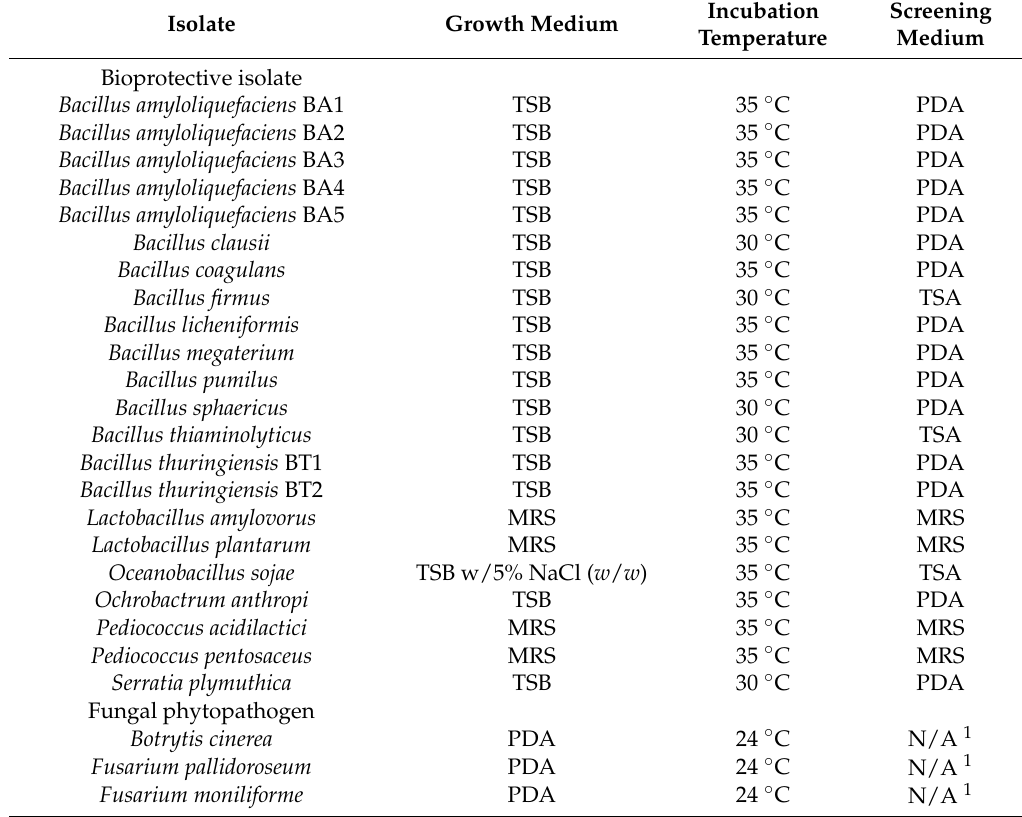
Table 1. Bioprotective isolates and fungal